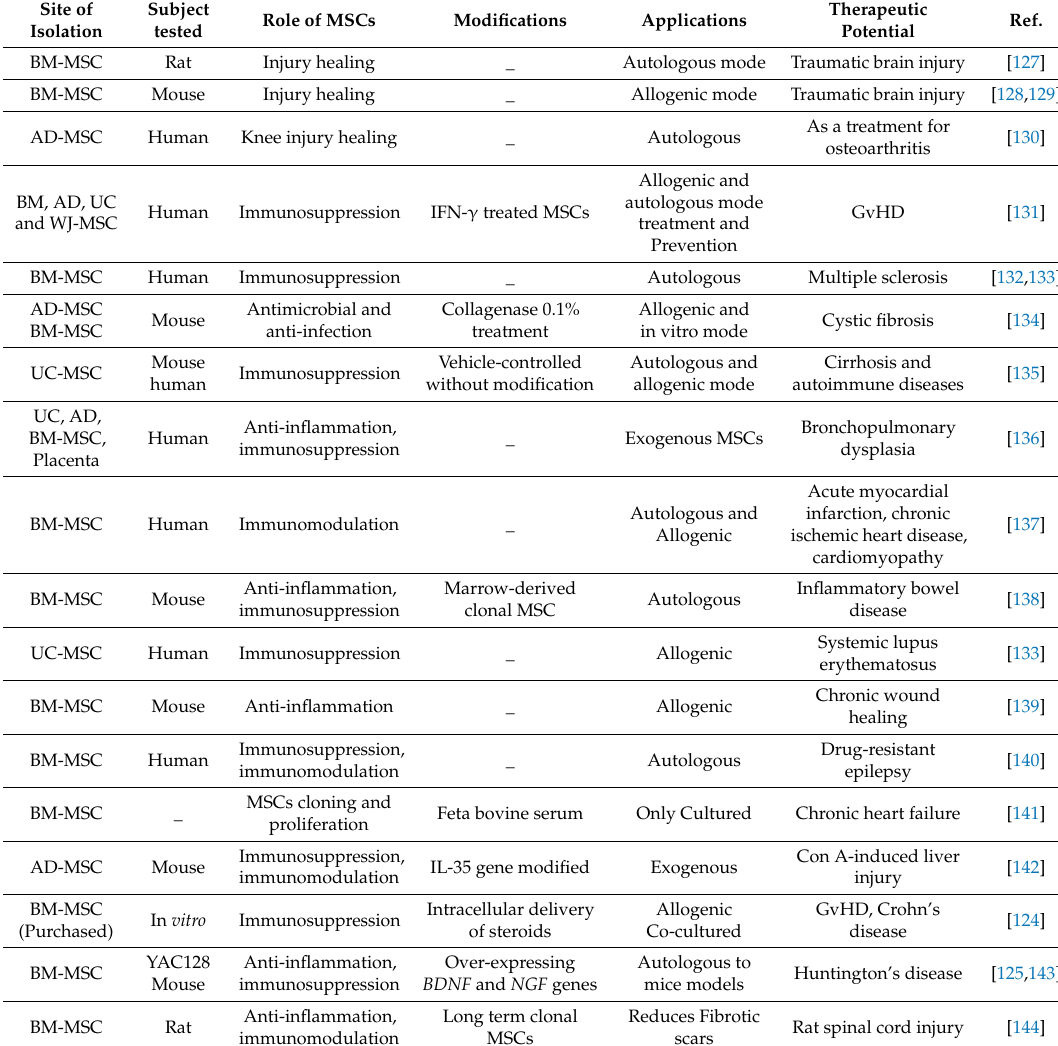
Table 1. Therapeutic potential of MSCs